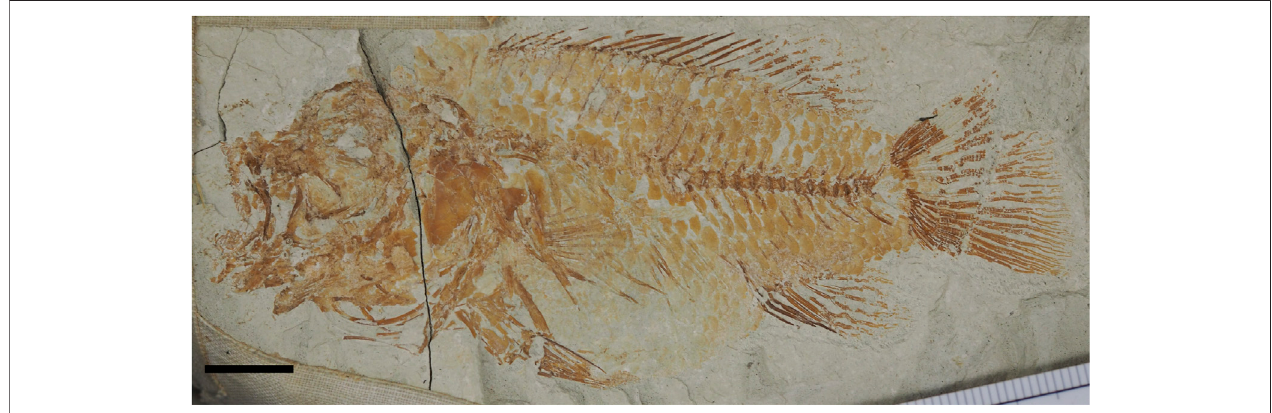
FIGURE 1 | Photograph of the holotype of Somalichromis hadrocephalus gen. et sp. nov., NHMUK P.29574. Scale bar equals 1 cm.